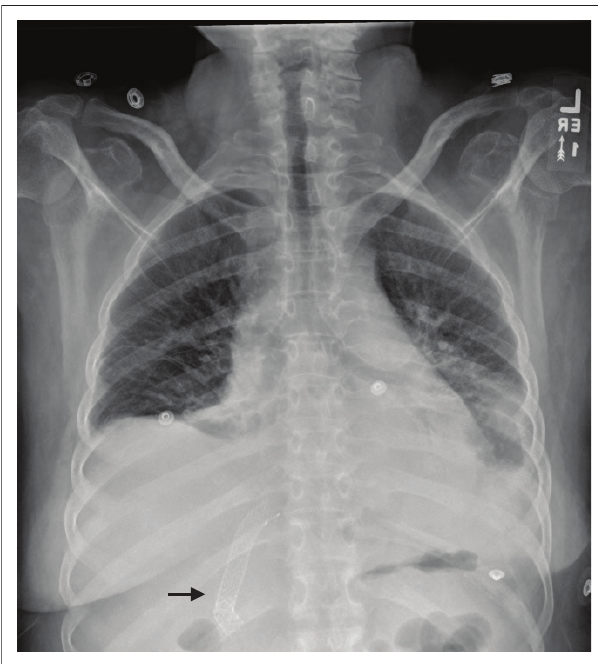
FIGURE 15: Transjugular intrahepatic portosystemic shunt stent in a 62-year-old female patient with portal